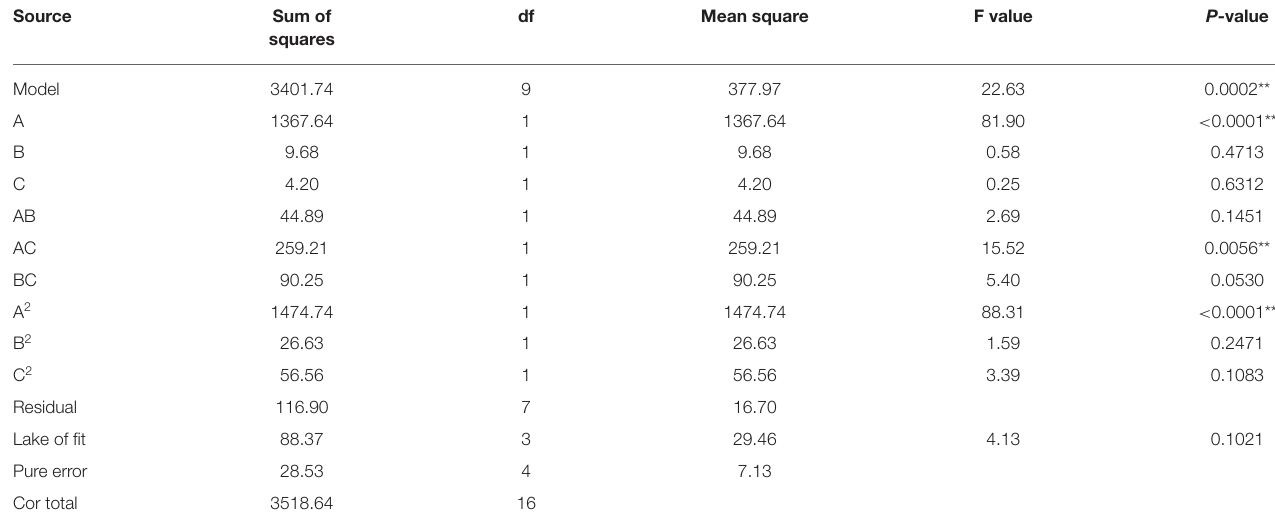
TABLE 4 | ANOVA for response surface quadratic model analysis of variance.